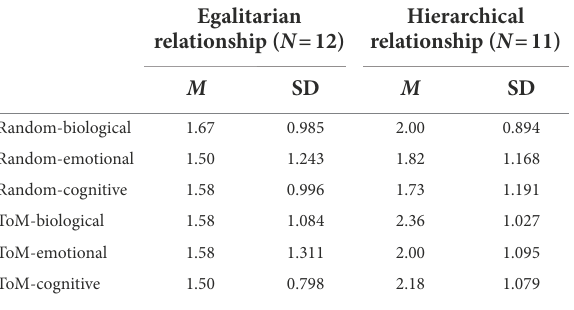
TABLE 3 Mean and standard deviation of agency attributions to ToM and random animations for child-IC relationship quality.